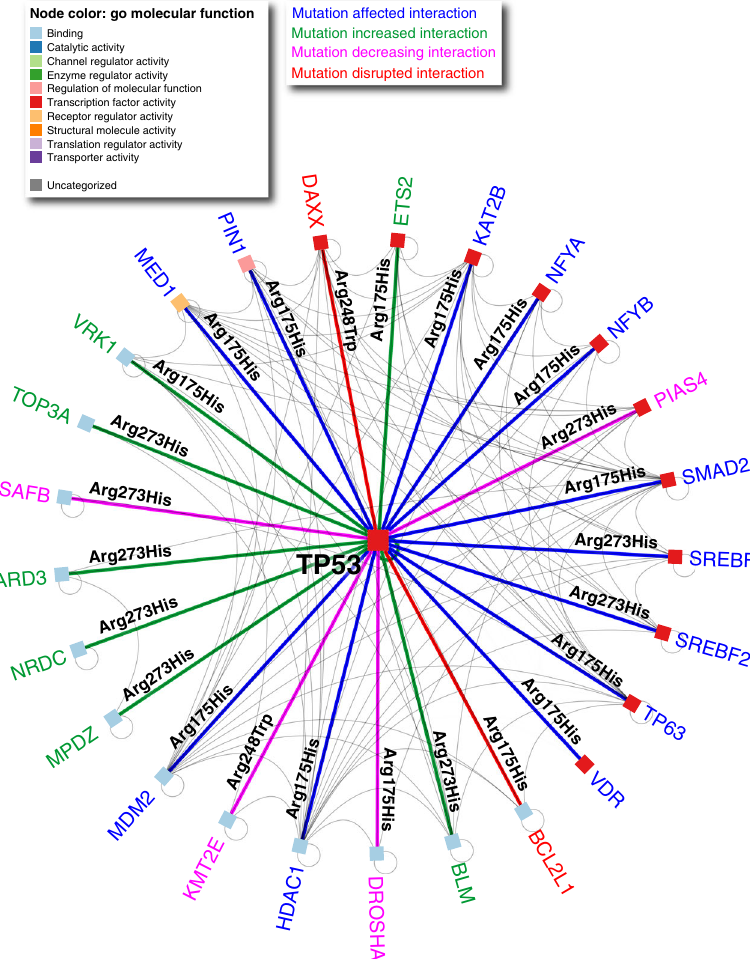
Fig. 5 Mutation-speci fi c TP53 interaction network. Survival-related patient mutation data 57 overlaid onto the mutation-speci fi c TP53 network derived from interactions from IID (version 2020-05) and mutation-speci fi c interaction data from IMEx. Survival-related mutations are shown on the network edges. It should be noted that many interactions are affected by many more mutations, but these are not necessarily linked to ovarian cancer. The network is visualised in NAViGaTOR 73 ver 3.0.13. Node colour corresponds to GO molecular function, edge colour represents the effect of the mutation on the